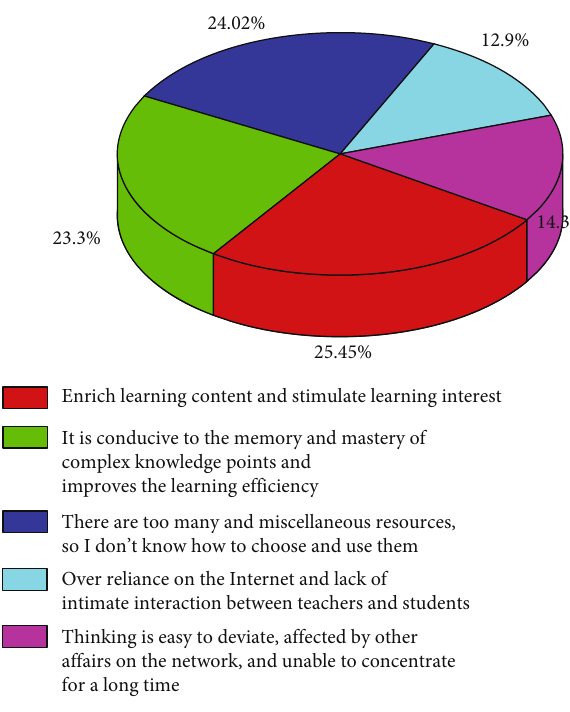
Figure 5: What impact do you think the use of online learning platform has on your learning?